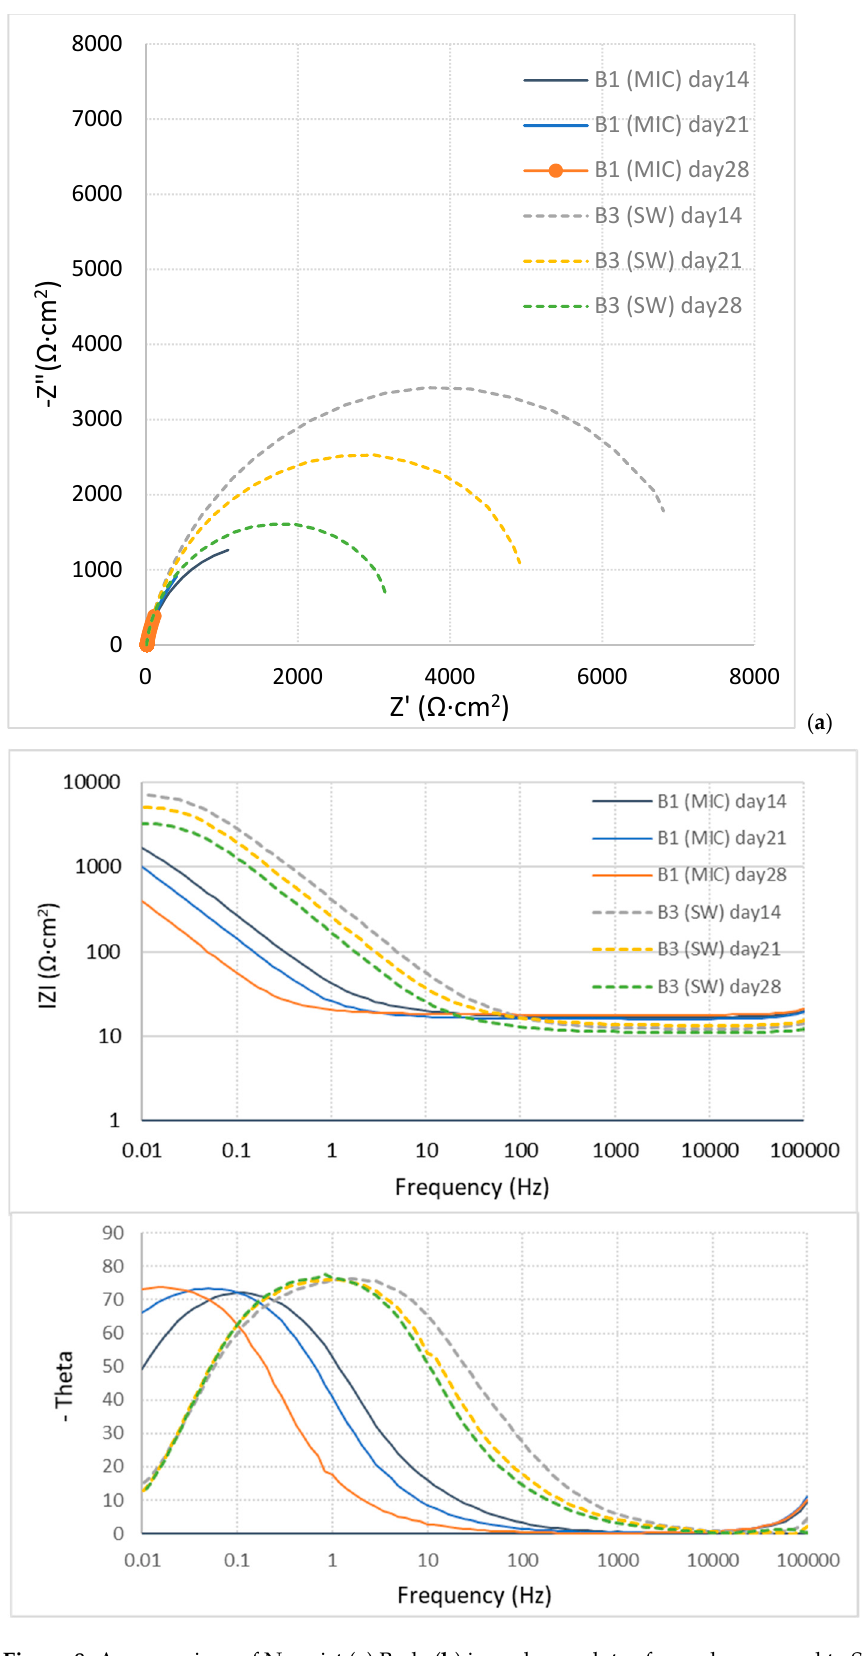
Figure 8. A comparison of Nyquist ( a ) Bode ( b ) impedance plots of samples exposed to SW + bacteria (B1 (MIC)) and exposed to SW (B3) for different time durations.